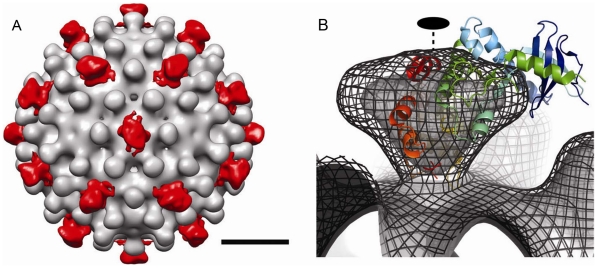
The difference map and modeling of SRPKΔ on Cp183 Capsid.(A) To isolate the density attributable to SRPKΔ, a difference map of SRPKΔ (red color) was calculated by subtracting Cp183 Capsid from Cp183 capsid/SRPKΔ and superimposed on the corresponding region of the 3-D reconstruction of Cp183 Capsid. The resulting densities of SRPKΔ were found located at each twofold axis. The bar represents 10 nm. (B) Cryo-EM density of Cp183 capsid/SRPKΔ fitted with SRPKΔ coordinates (as shown in the cartoon representation) viewed at twofold position. The 3-D reconstructions rendered in isosurface and isomesh modes represent 100% contour and a 1 σ contour, respectively. The fitting was performed manually to place the SRPKΔ active site close to the twofold pore and maximize envelopment of the large lobe of SRPKΔ in cryo-EM density. The twofold axis is marked with a dashed line.